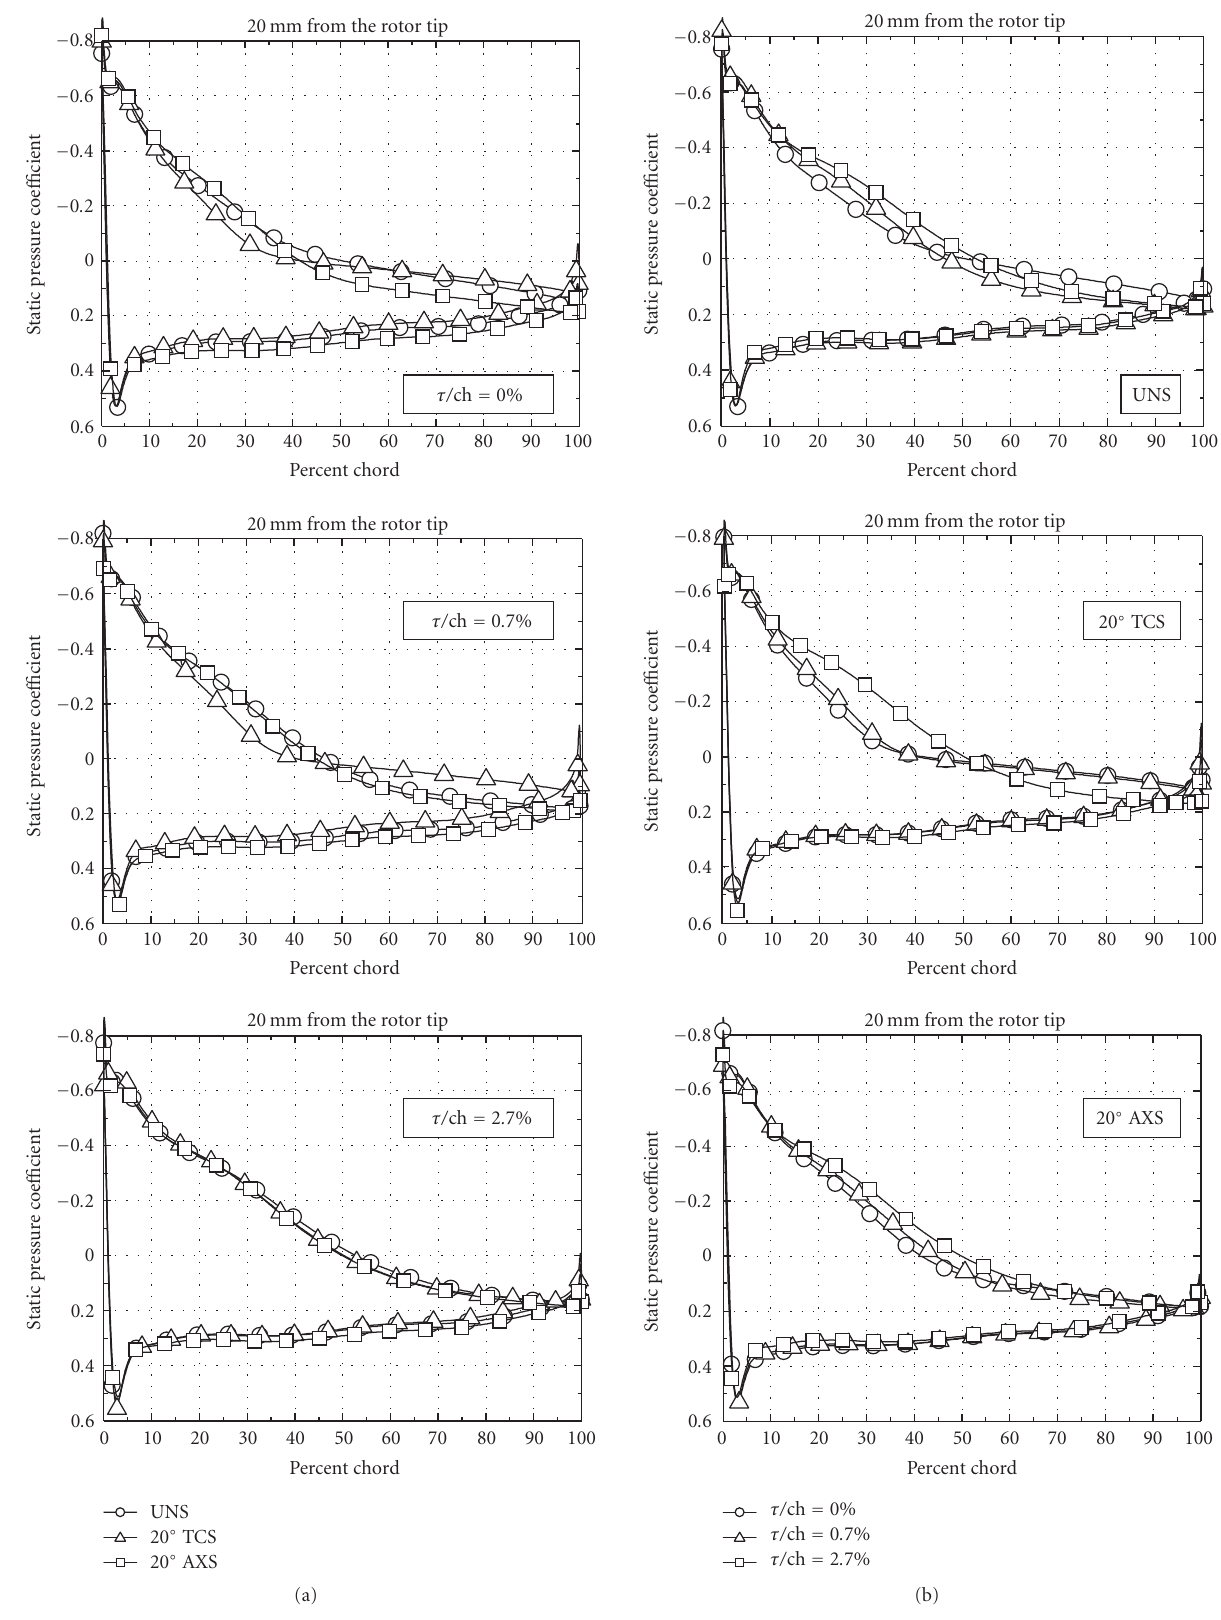
Figure 3: Static pressure distribution on the blade at S 3 , φ =